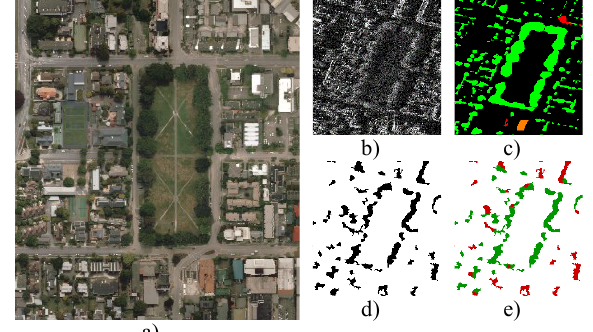
Figure 9 . Exemplary area of vegetation: a) Optical image, b) SAR image, c) reference map, d) screening result, and e) classification result.